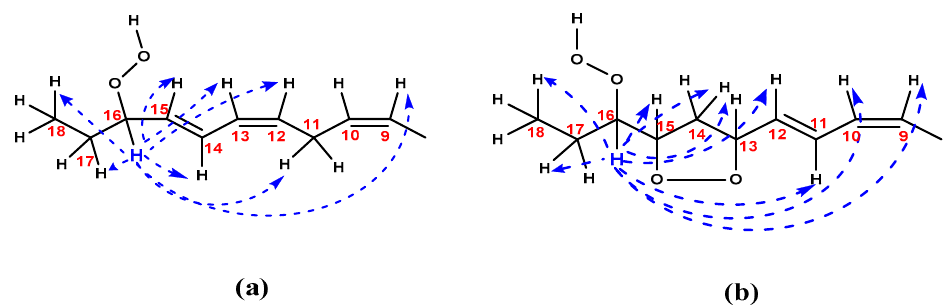
Figure 7. Schematic presentation of the selective 1D TOCSY correlations which were observed in the case of the 9- cis , 12- cis , 14- trans -16-OOH hydroperoxide ( a ), and the 9- cis , 11- trans -16-OOH endo -hydroperoxide ( b ) of the methyl linolenate primary oxidation products.